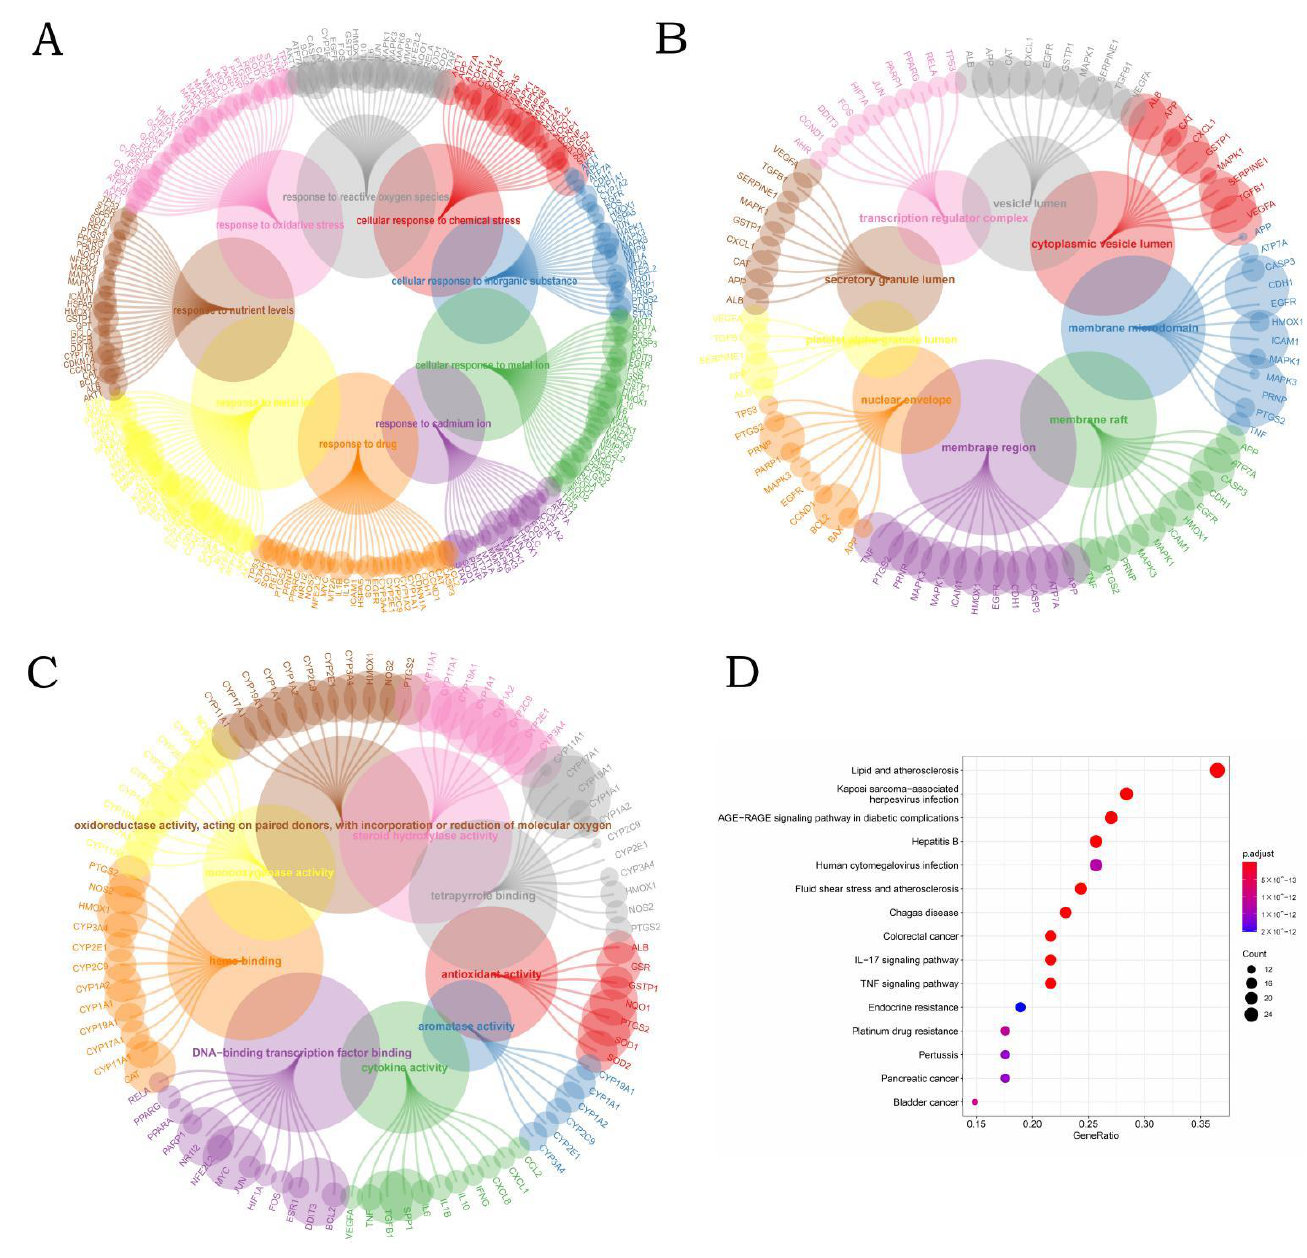
Figure 2. Circle plots were used to explore GO and KEGG enrichment pathways among the co-interaction genes: ( A ) top terms from the GO BP enrichment analysis; ( B ) top terms from the GO CC enrichment analysis; ( C ) top terms from the GO MF enrichment analysis; ( D ) top 4 terms from the KEGG enrichment analysis.